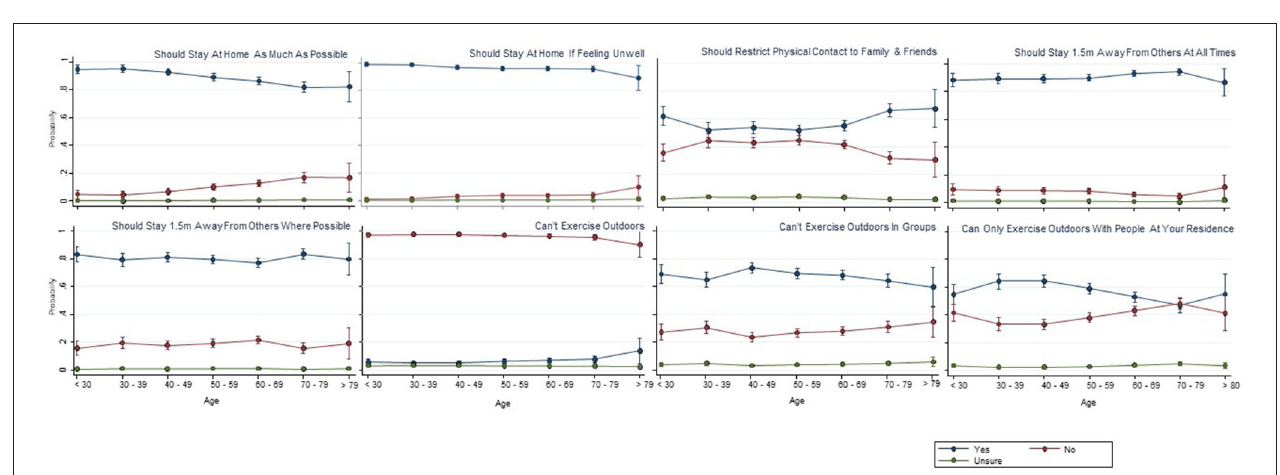
FIGURE 3 | Social distancing means that you ... (probability of each response with